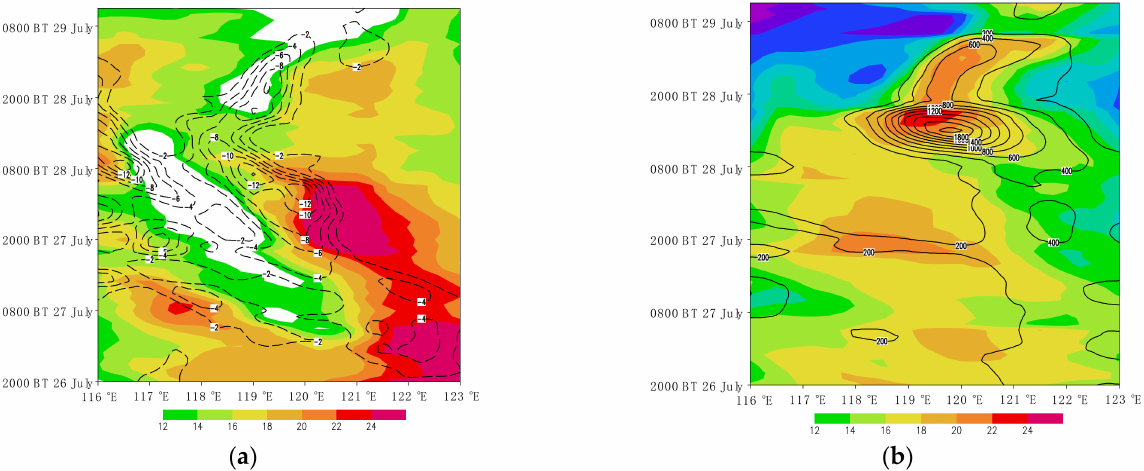
Figure 16. Meridional-time cross-section of ( a ) 925-hPa wind speed (shaded, unit: m s − 1 ) and divergence (black dashed line, unit: 10 − 6 s − 1 ), and ( b ) CAPE (black line, unit: J kg − 1 ) and 925-hPa specific humidity (shaded, unit: g kg − 1 ), averaged from 31.5 ◦ N to 33.5 ◦